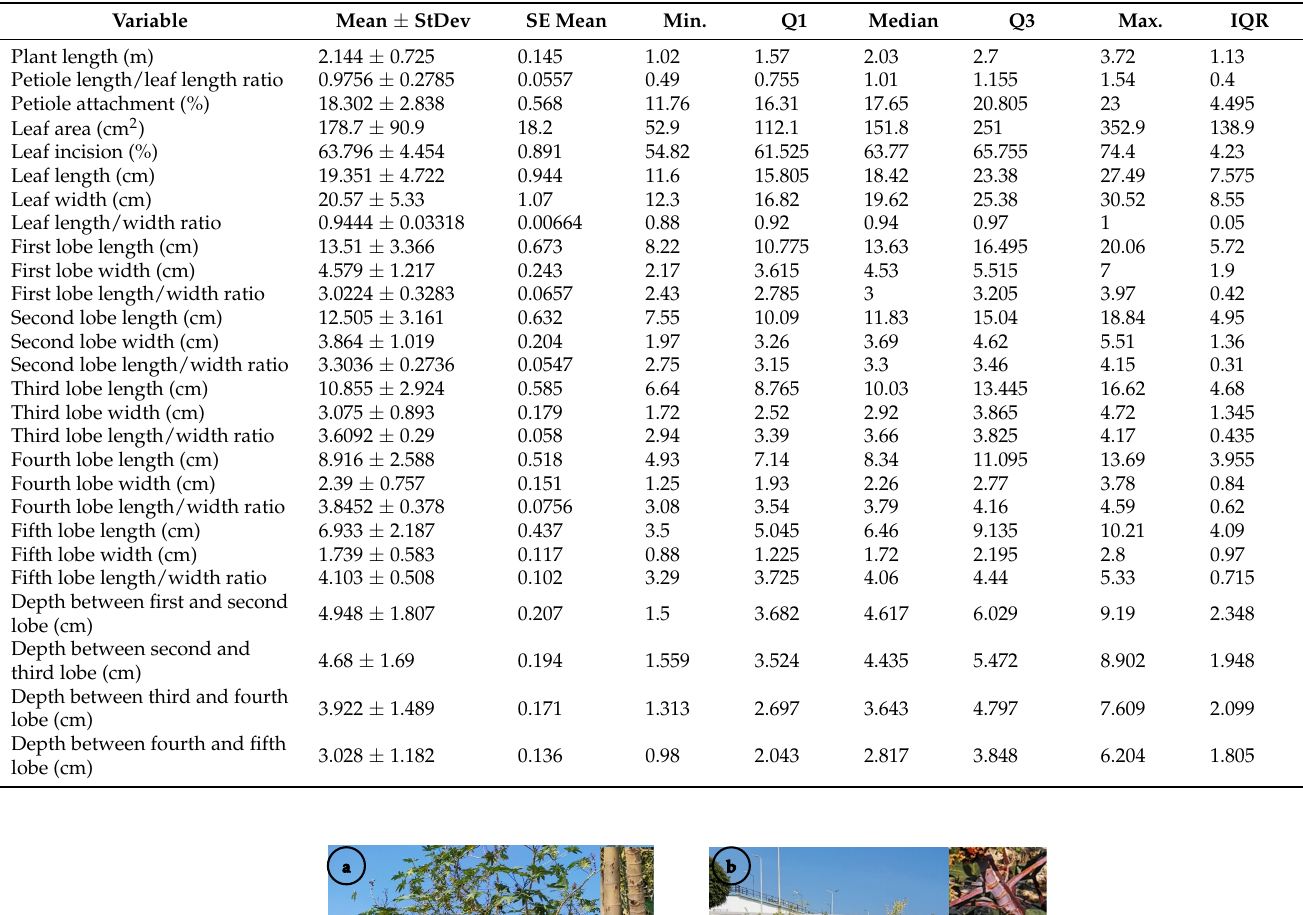
Table 2. Descriptive quantitative data of Ricinus communis vegetative morphometry.